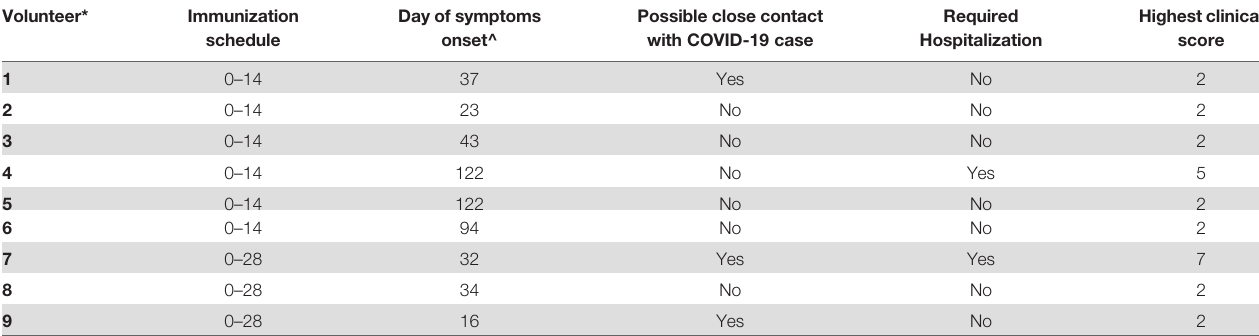
*Gray shading, female; no shading, male. ^ Days after the administration of the second dose.